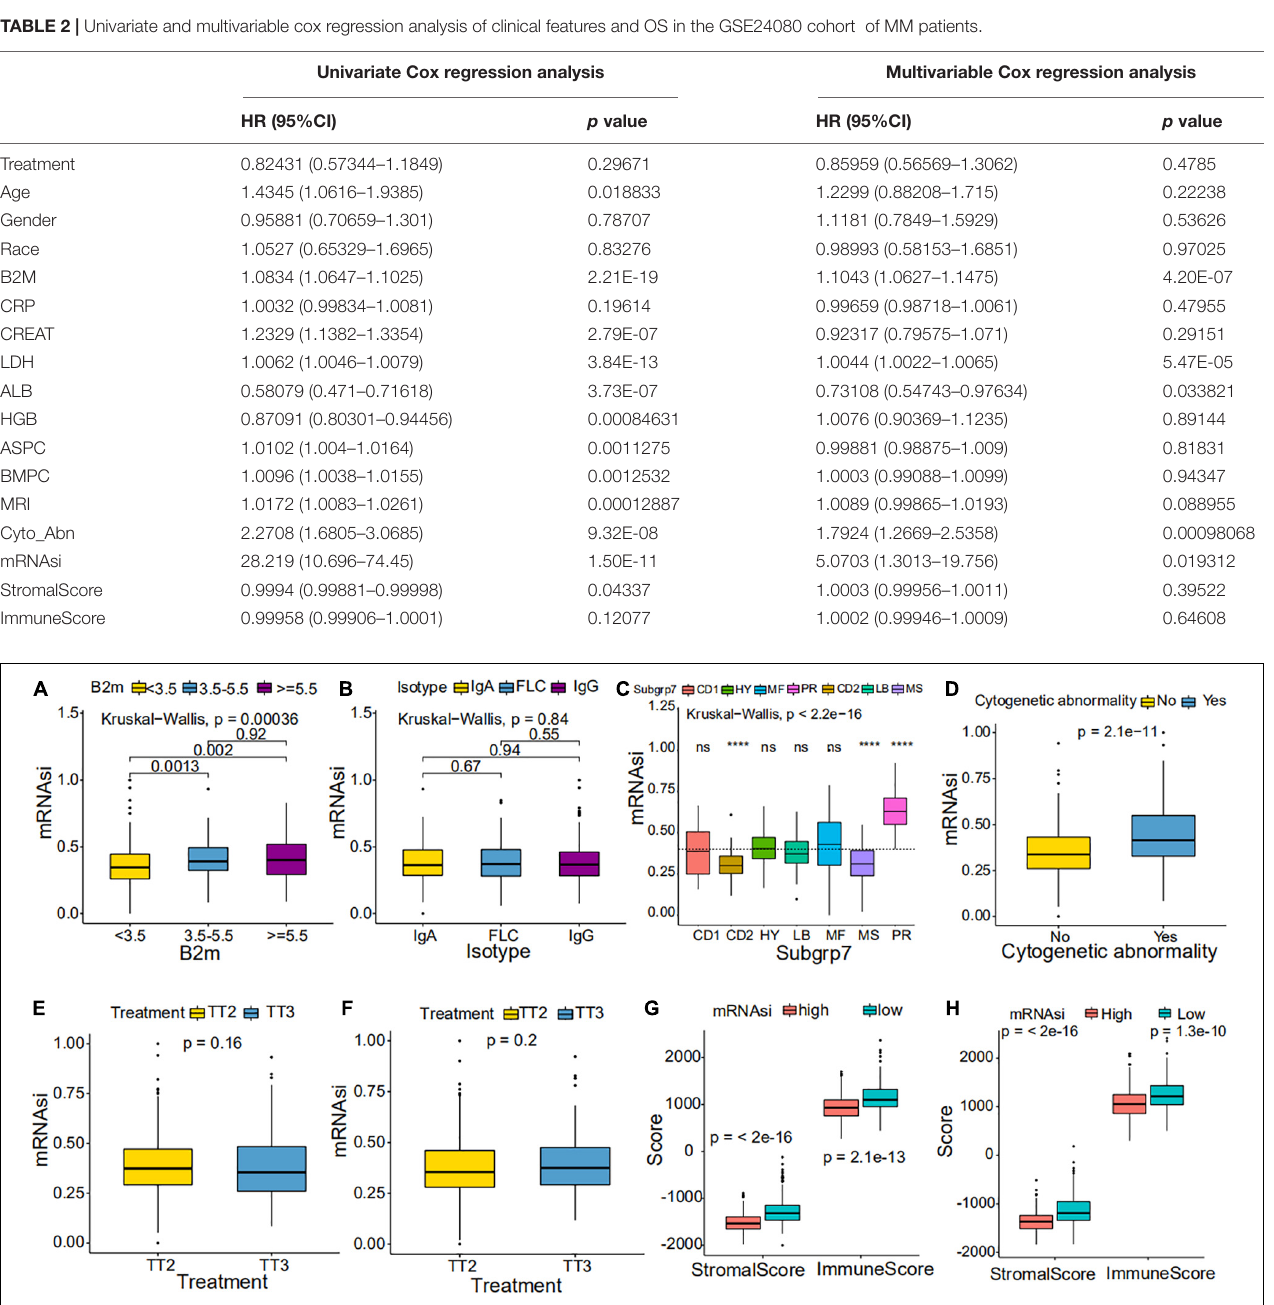
FIGURE 4 | Clinical characteristics in low mRNAsi and high mRNAsi MM patients. (A,B) Differences in mRNAsi between distinct B2M groups (A) and isotype groups (B) in patients with MM. The upper and lower ends of the boxes represent the interquartile range of values. The lines in the boxes represent median values. (C,D) Difference in mRNAsi between distinct subgroups (C) and cytogenetic abnormalities groups (D) in patients with MM. (E,F) Difference in mRNAsi between distinct treatment regimen groups in patients of the GSE24080 cohort (E) or the GSE4204 cohort (F) . (G,H) Difference in stromalscore and immunescore between high